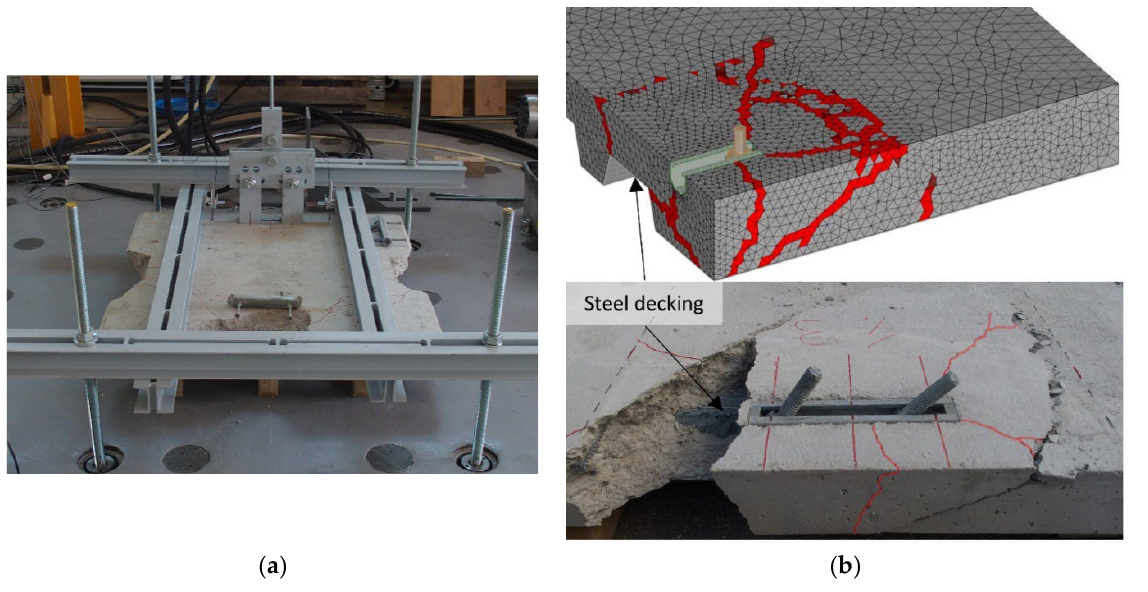
Figure 2. ( a ) Experimental setup; and ( b ) comparison between experimental and numerical breakout patterns [6].